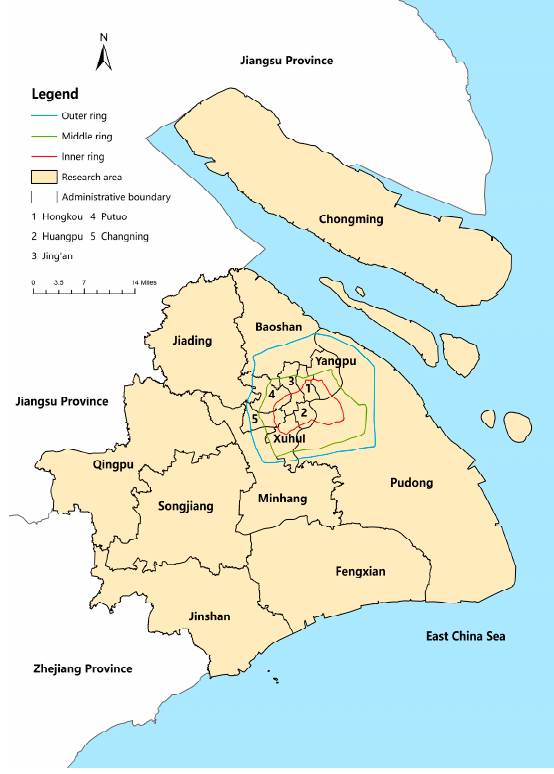
Figure 4. Study area.